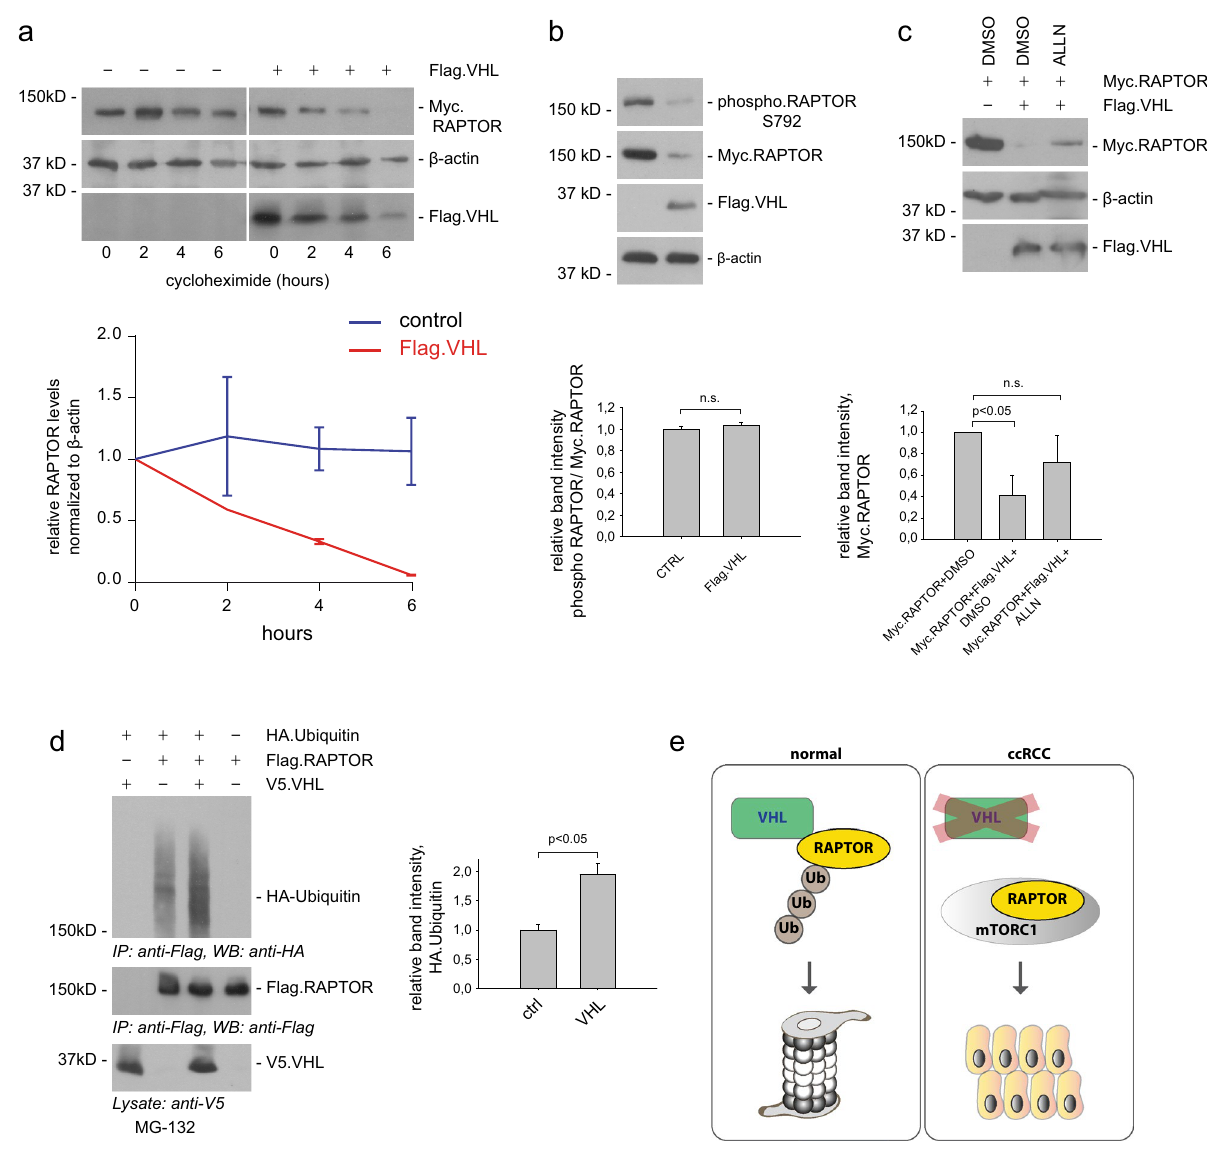
Figure 5. VHL leads to ubiquitination of RAPTOR. ( a ) VHL impairs RAPTOR protein stability. HEK293T cells were transfected with plasmids expressing Flag-VHL and Myc-RAPTOR. 24 h after transfection cells were treated with cycloheximide (40 μg/mL) for the indicated times. The levels of VHL and RAPTOR were monitored by Western blot analysis. β-actin levels were used as a loading control. Lower panel shows relative RAPTOR levels normalized to β-actin. Full-length blots are presented in Supplementary Fig. 4. ( b ) RAPTOR phosphorylation at Serine 792 is independent of VHL. 293 T cells were transiently transfected with Flag.VHL and Myc. RAPTOR. Lysates were analyzed by immunoblotting for anti- phospho RAPTOR S792, anti-Myc and anti-Flag antibody. β-actin was used as loading control. Quantification of three independent experiments. t test; mean values ± SEM. n.s., not significant. Full-length blots are presented in Supplementary Fig. 4. ( c ) Proteasome inhibition prevents RAPTOR degradation by VHL. HEK293T cells were co-transfected with Myc.RAPTOR and Flag.VHL and treated with the proteasome inhibitor ALLN (30 µM, overnight) as indicated. DMSO was used as vehicle control. Cell lysates were subjected to immunoblotting using anti-Flag and anti-Myc antibody. Quantification of three independent experiments. t test; mean values ± SEM. n.s., not significant. Full-length blots are presented in Supplementary Fig. 4. ( d ) Polyubiquitinylation of RAPTOR is induced by VHL. HEK293T cells were transfected with HA.Ubiquitin, Flag.RAPTOR, and V5.VHL as indicated. After transfection the cells were treated with the proteasome inhibitor MG132 (5 µM) for 12 h. Flag.RAPTOR was immunoprecipitated with anti-Flag antibody (middle panel) and analyzed for co-precipitated Ubiquitin with anti-HA antibody (upper panel). Cell lysates were used for detecting expression of VHL by anti-V5 antibody (lower panel). Quantification of three independent experiments. t test; mean values ± SEM. Full-length blots are presented in Supplementary Fig. 4. ( e ) Model depicts the modulation of RAPTOR/mTORC1 by VHL. VHL interacts with RAPTOR and promotes RAPTOR degradation by ubiquitination. Loss of VHL enhances RAPTOR protein stability, thereby facilitating mTORC1 signaling and tumor